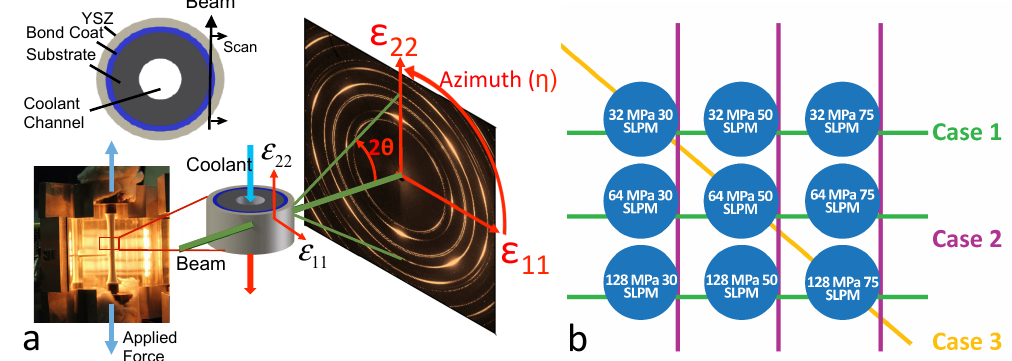
Figure 1. ( a ) view of specimen with attached thermocouple placed in furnace and schematic of experimental methodology with nomenclature of determined strain. ( b ) Multivariable matrix for Case 1 (constant load, variable flow in standard liters per minute), Case 2 (constant flow, varying mechanical loading), and Case 3 (extrema loading